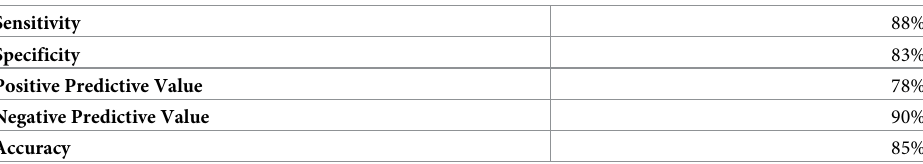
Table 3. Omega pattern diagnostic performance study day